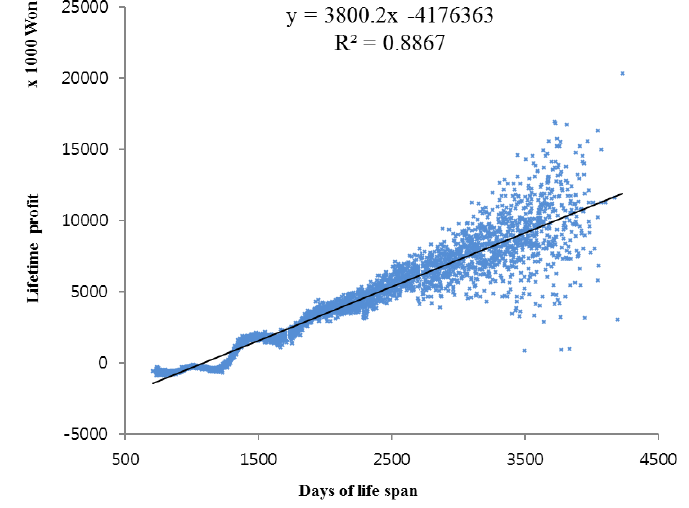
Figure 1. Distribution of lifetime profit (1,000 Won) according to days of life